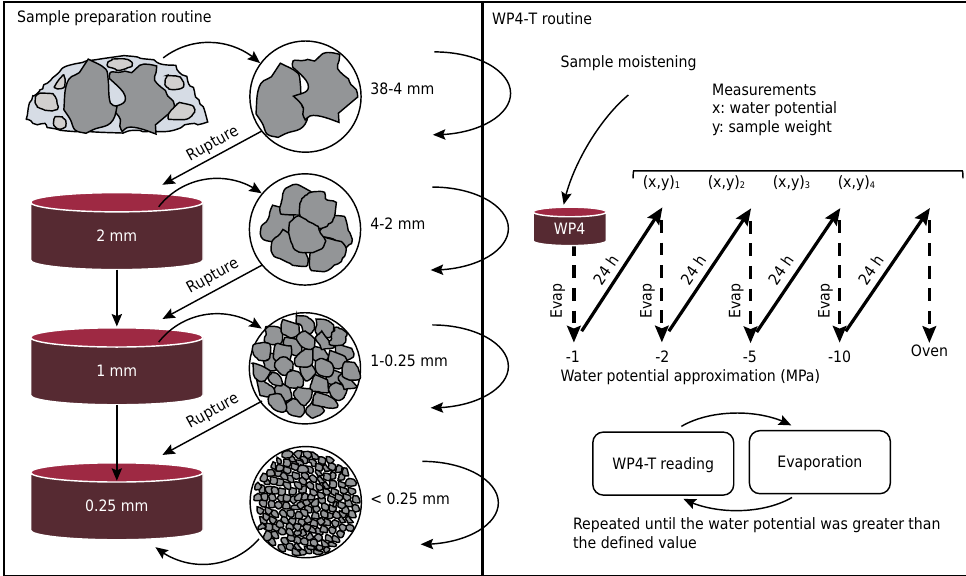
Figure 3. Schematic view of how the samples were prepared and water potential was